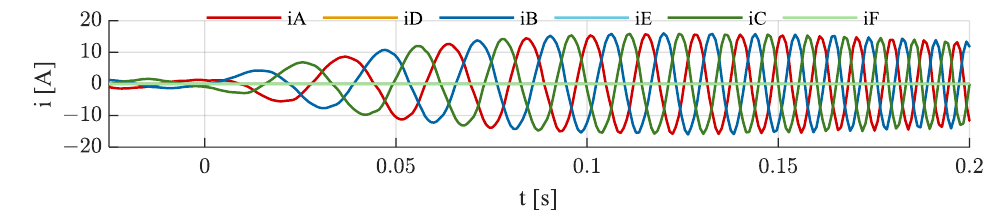
Figure 15. Phase current during the startup transient of the emergency three-phase operation.